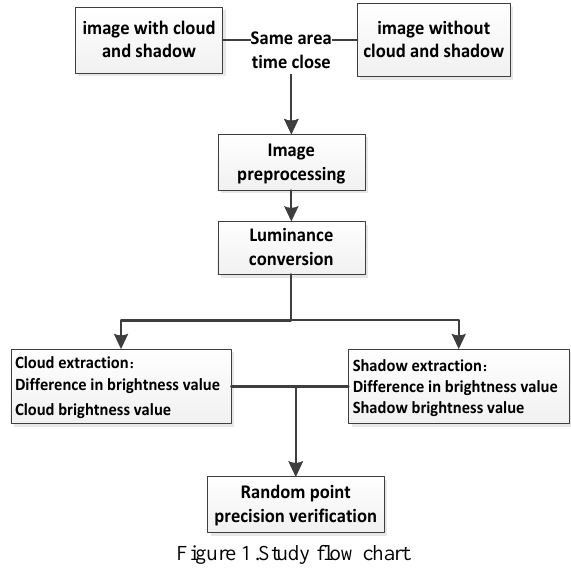
Figure 1.Study flow